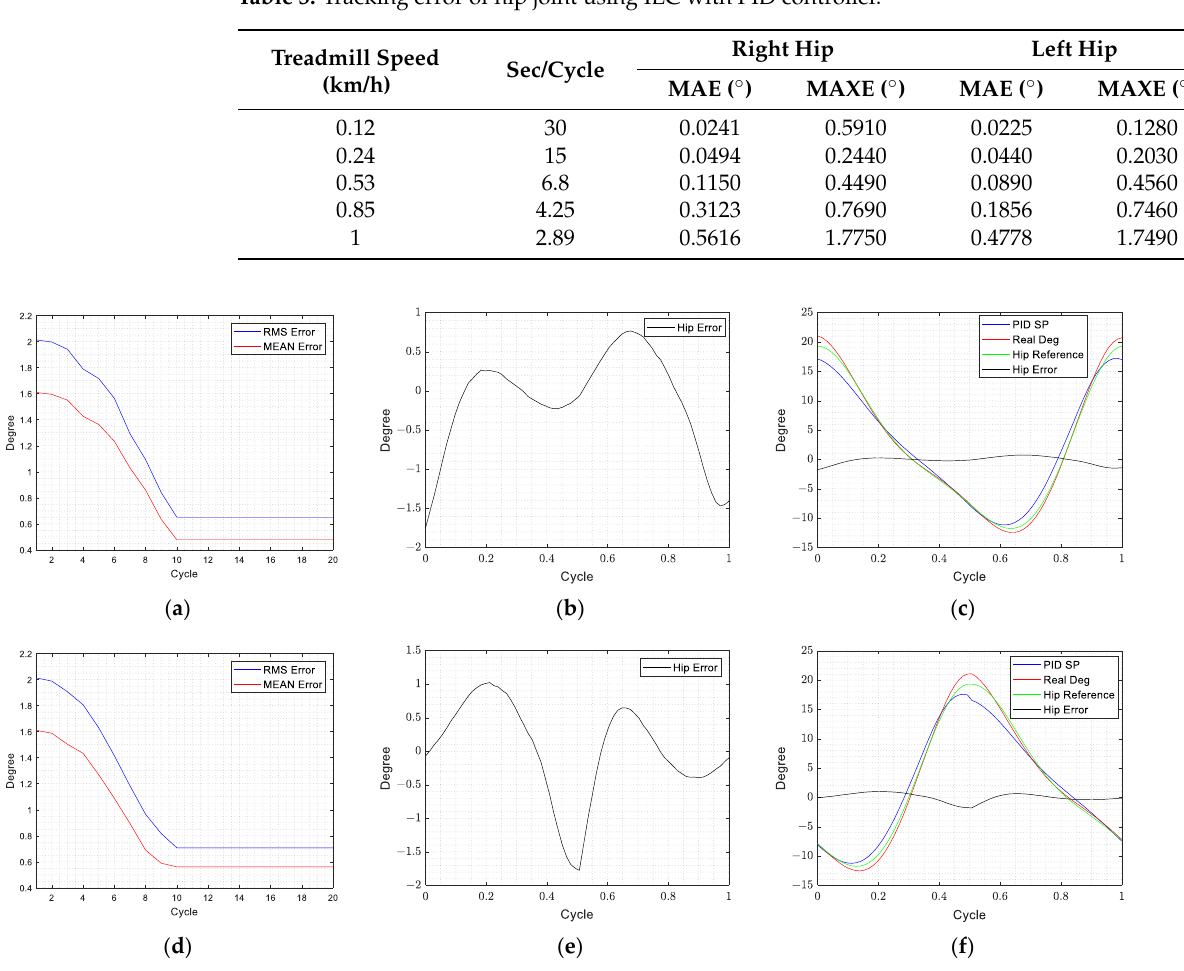
Figure 12. ILC with PID learning at a treadmill speed of 1 km/h. ( a ) (Left hip) The number of ILC iterations and the RMS/MEAN error of the trajectory; ( b ) (Left hip) The tracking error diagram of the best gait cycle; ( c ) (Left hip) The tracking response of the best gait cycle.; ( d ) (Right hip) The number of ILC iterations and the RMS/MEAN error of the trajectory; ( e ) (Right hip) The tracking error diagram of the best gait cycle; ( f ) (Right hip) The tracking response of the best gait cycle. After the hip joint test, the knee joint of the proposed system is tested by using the PID controller. The PID parameters (P: 0.203, I: 0.006, D:0.001) are obtained by the Z-N method and the ILC structure is as shown in Figure 13. The knee joints are also tested at five rehabilitation speeds; the tracking results are shown in Table 4. According to the re-